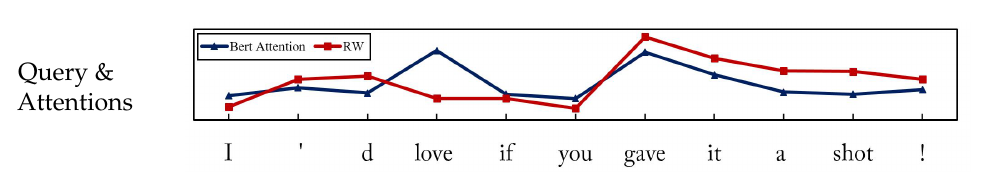
Table 6. The examples that show the effectiveness of the response weight in RGRW.